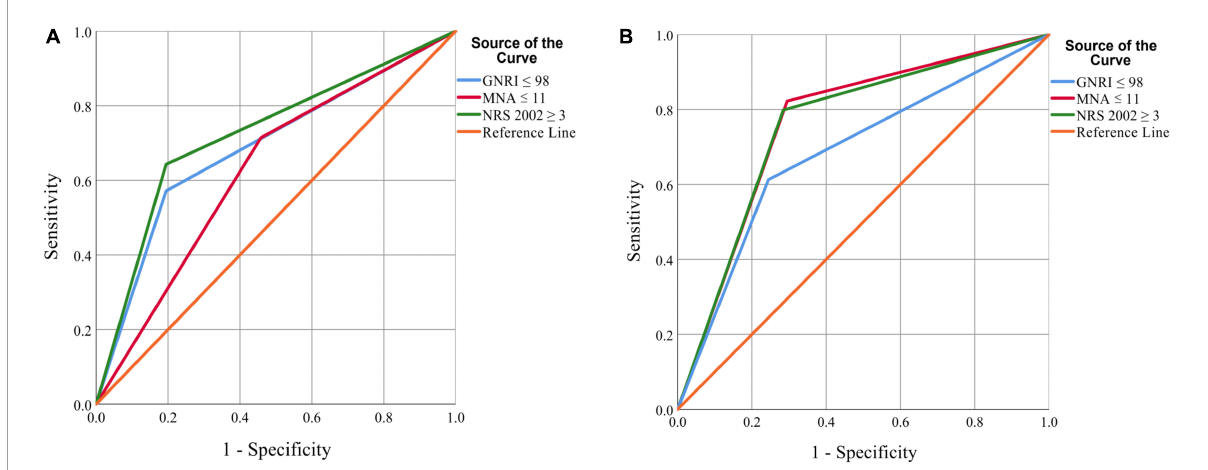
FIGURE2 ROC curves of the three nutritional screening scales in diagnosing malnutrition in patients younger (A) or older than 65 years (B) . The area under the curve (AUC) is 0.688, 0.628, 0.724 for GNRI, MNA-SF, and NRS 2002 in patients younger than 65 years, and is 0.684, 0.764, 0.757 for GNRI, MNA-SF, and NRS 2002 in patients aged 65 years or older.